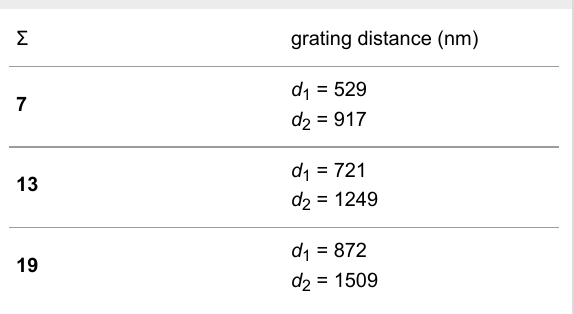
Table 2: Distances between coincident sites on the eye of the Mourning Cloak butterfly. Σ grating distance